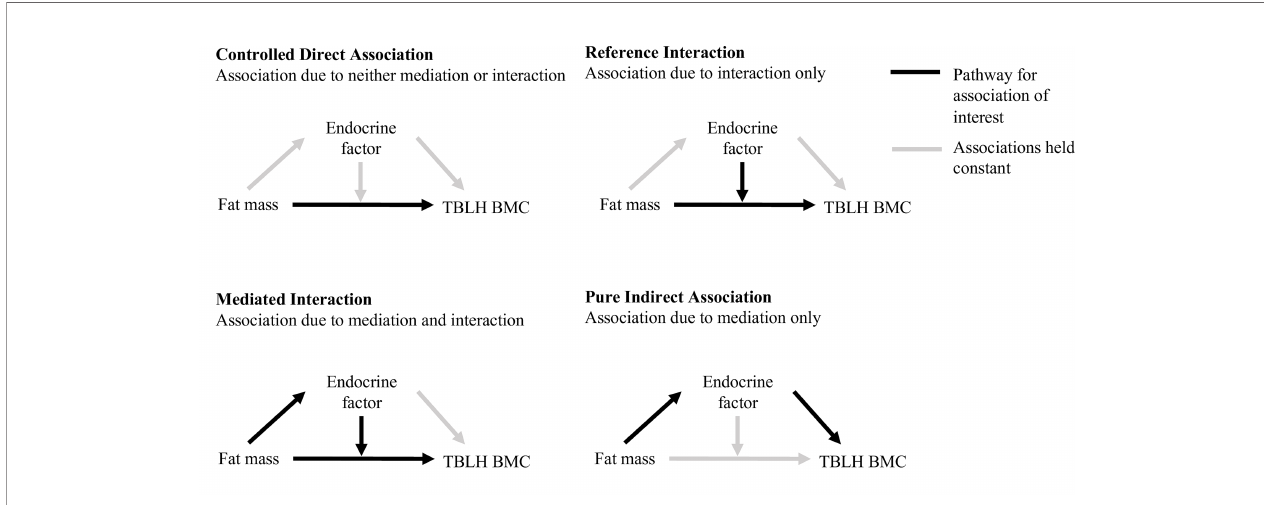
FIGURE 2 | Components of the 4-way decomposition, as described by VanderWeele (20), of the total association between fat mass with TBLH BMC. Total body less head bone mineral content, TBLH